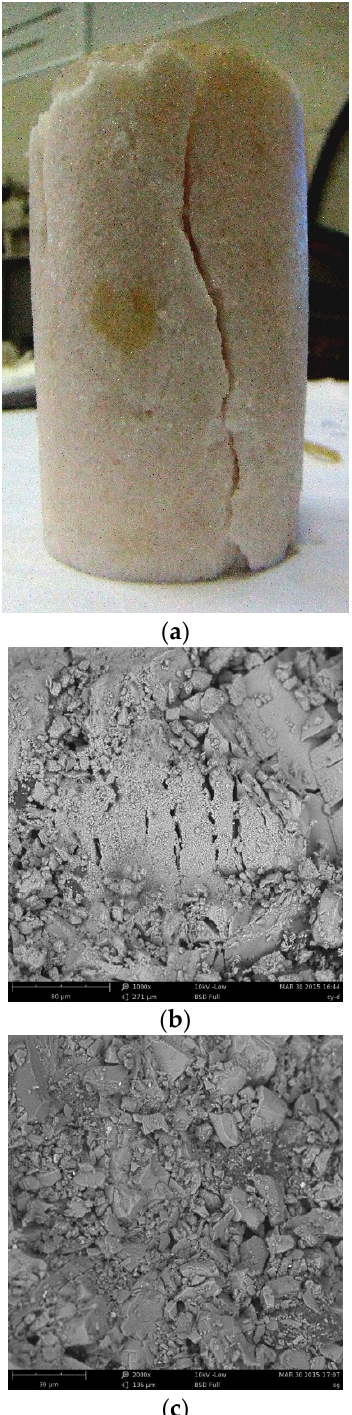
Figure 8. ( a ) Failure condition of rock salt after experiment. SEM images of micro cracks for ( b ) the first circle and ( c ) the complete circle.